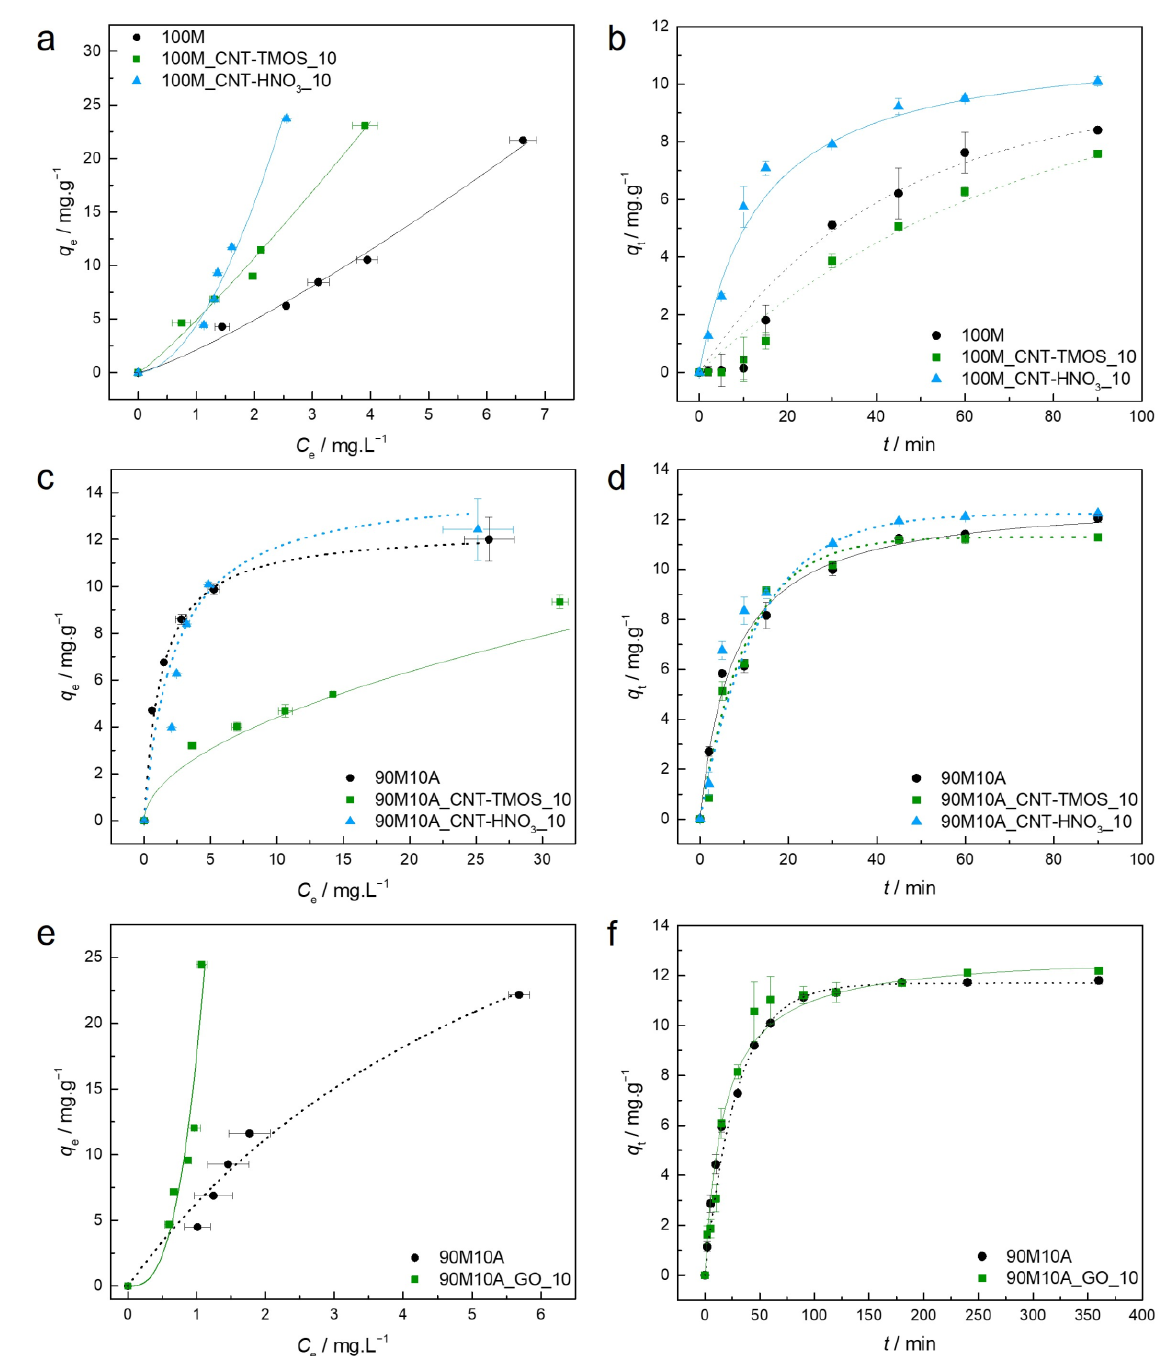
Figure 8. ( a , c , e )—Experimental equilibrium data and the best fitted isotherm model for adsorption of naproxen into the studied aerogels (dotted line—Langmuir; solid line—Freundlich). ( b , d , f )— Representative plots of the fit of non-linearized form of pseudo-first order (dashed line) or pseudo- second order (solid line) to the data of experimental adsorption capacity as function of time, for the studied adsorbents towards naproxen ( C 0 = 25 ppm, 15 rpm, 20 °C). For the 90M10A batch of samples with CNTs, the AIC showed that for 90M10A and 90M10A_CNT-HNO 3 _10, the Langmuir model has the best adjustment to the data, with the shape of the isotherms (Figure 8) and the RL values (Table S11) indicating a favorable